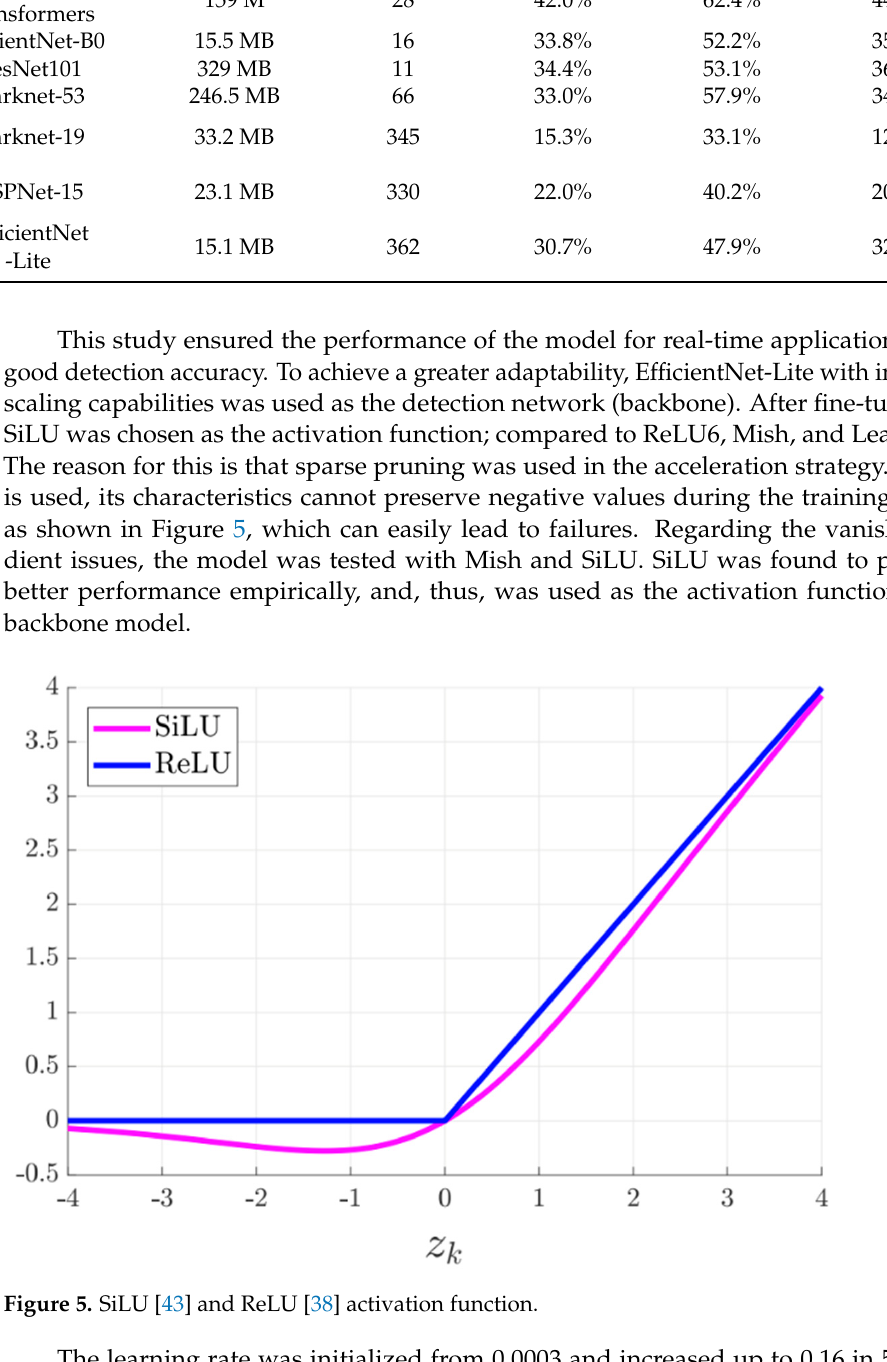
Table 1. Comparison among the state-of-the-art detectors.